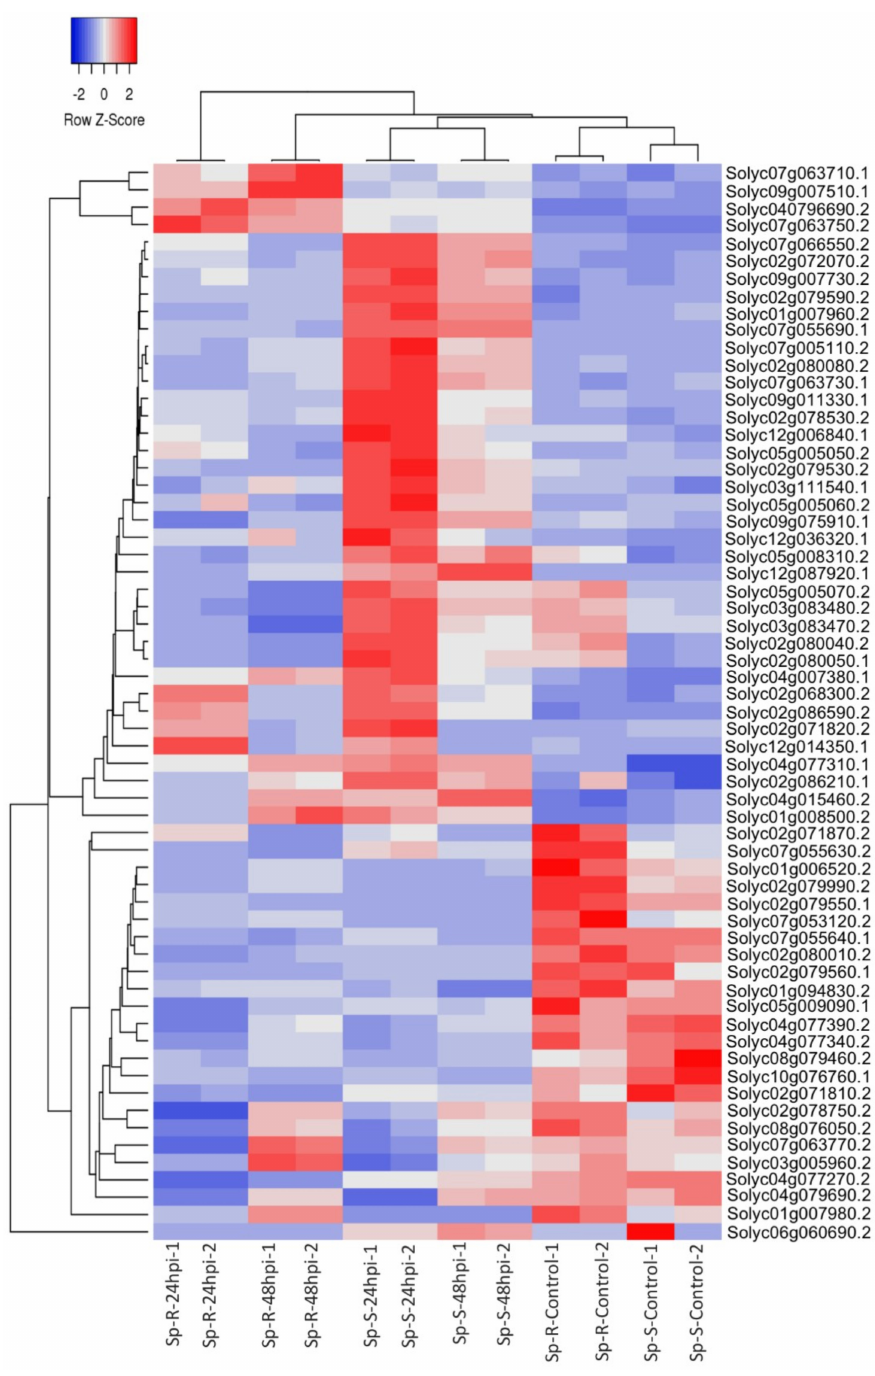
Figure 10. Heatmap showing expression profiles of DEGs encoding DUF26 type receptor like kinases (RLKs). The gradient scale shows scores of DEGs, where red represents most induced expression and blue depicts highest